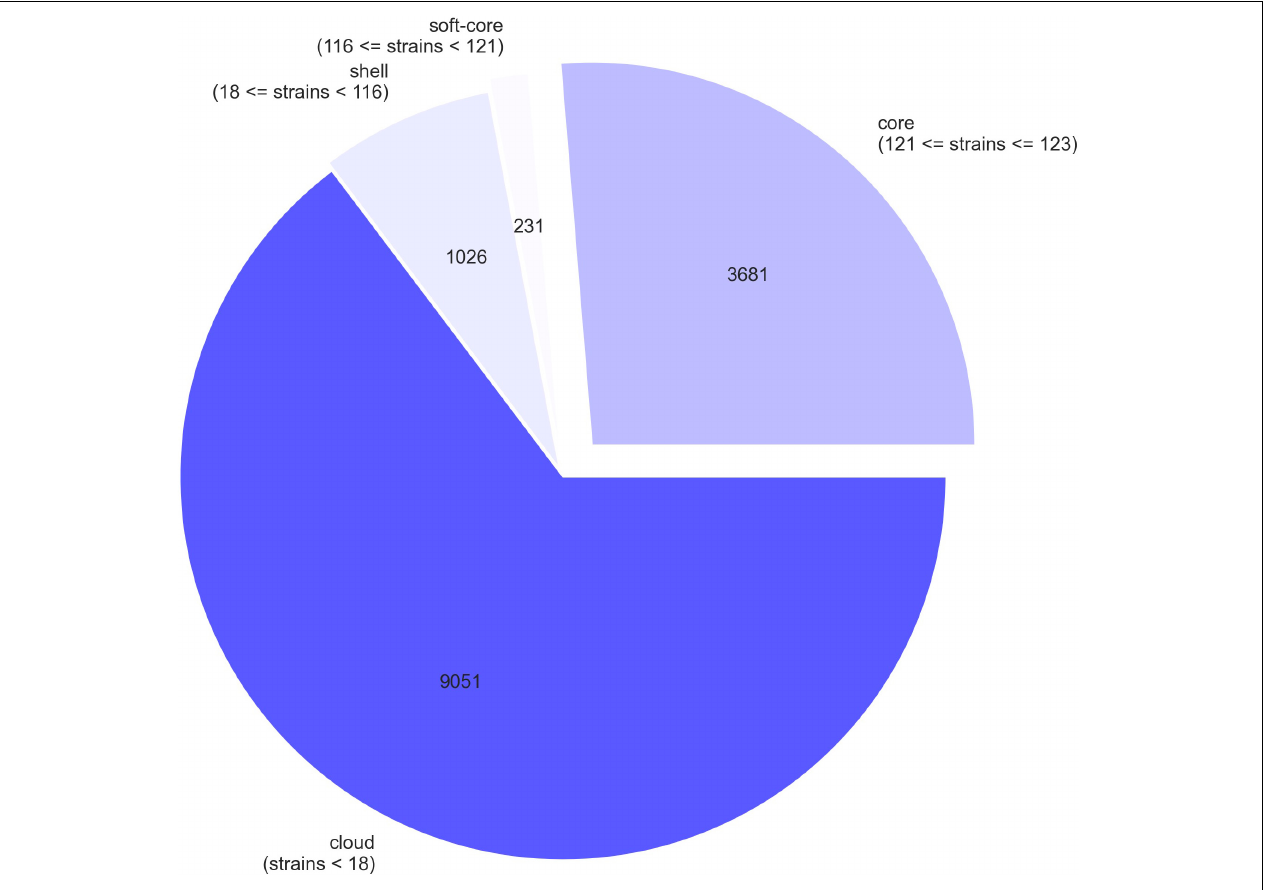
FIGURE 1 | A pie chart representation of pangenome of 123 E. coli strains. The chart shows the proportion of core and accessory genes present in the